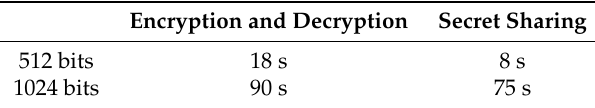
Table 2. Performance